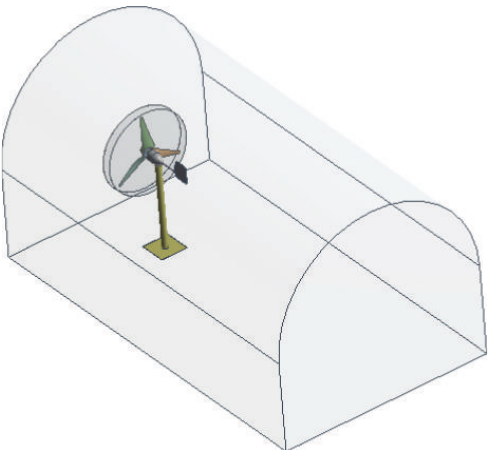
Figure 11: Computational domain.